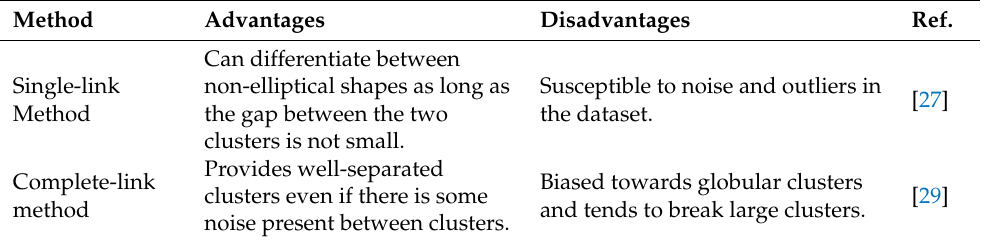
Table 1. Advantages and disadvantages of agglomerative hierarchical clustering